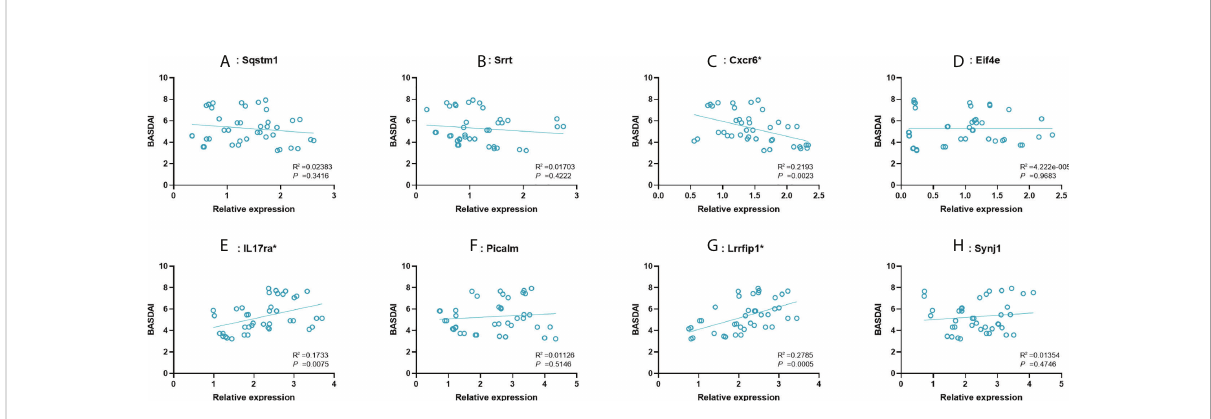
FIGURE 5 Correlation between expression value of 8 signi fi cant mRNAs and BASDAI. (A – H) : Sqstm1, Srrt, Cxcr6, Eif4e, IL17ra, Picalm, Lrr fi p1, Synj1. R 2 , correlation coef fi cient. BASDAI, Bath Ankylosing Spondylitis Disease Activity Index; VAS, visual analog